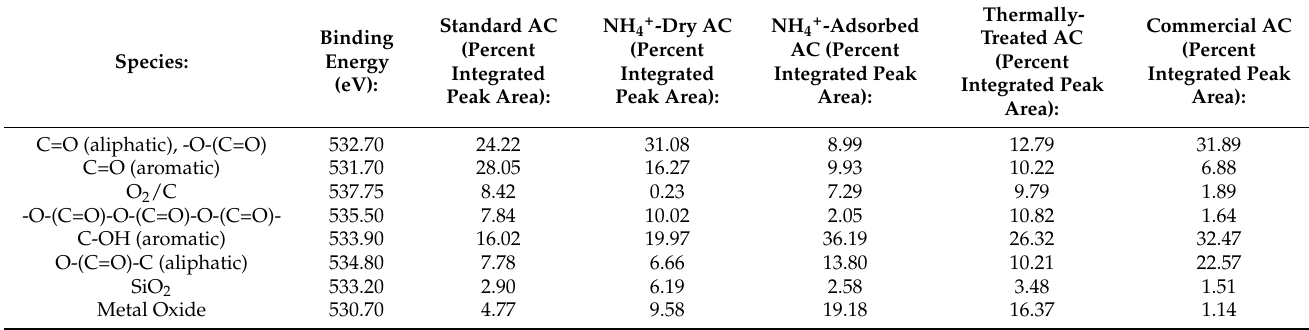
Table 2. Oxygen atom percent speciation from deconvolution of the XPS O1s peak for the various activated carbons investigated